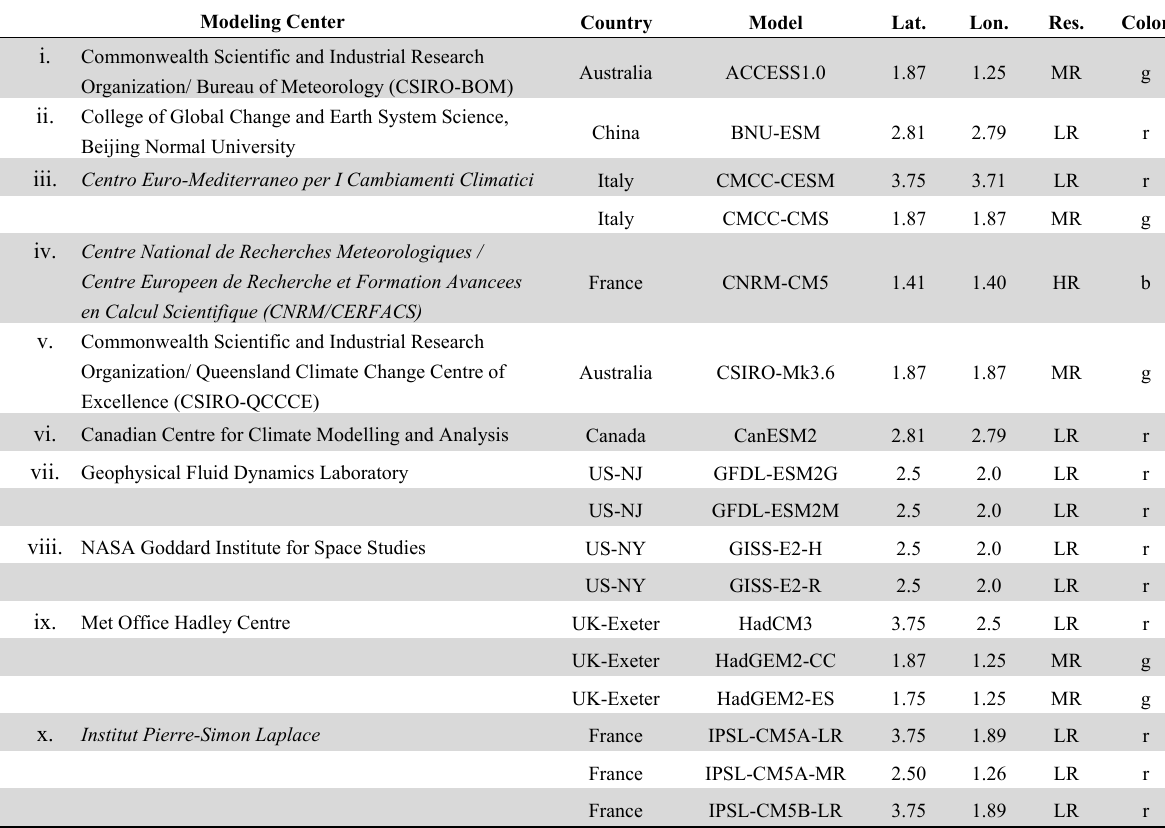
Table 1. Coupled Model Intercomparison Project (CMIP5) general circulation models (GCMs) considered in this study; blue (b), green (g) and red (r). Modeling Center Country Model